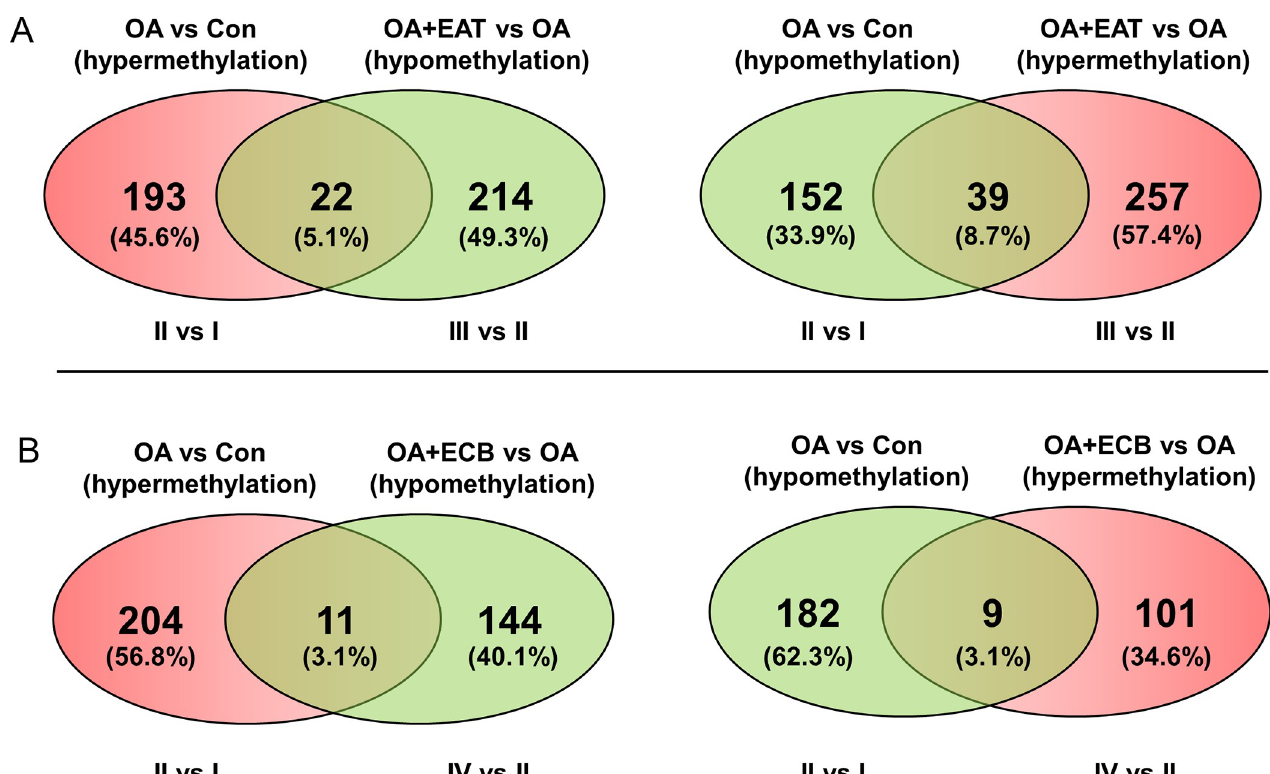
Fig 2. Venn diagram of selected DMRs. (A) Venn diagram showing numbers of DMRs in the OA (II) vs control (I) and OA+EAT (III) vs OA (II) comparisons. (B) Venn diagram showing numbers of DMRs in the OA (II) vs control (I) and OA+ECB (IV) vs OA (II) comparisons. Red and green colors indicated hypermethylation and hypomethylation,